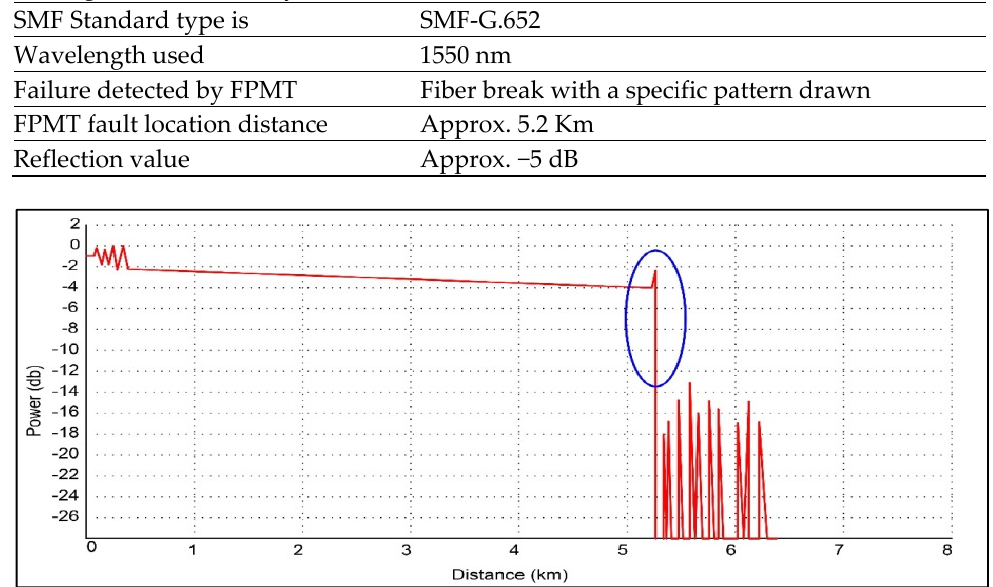
Figure 8. Fiber break event (standard SMF G.652 at 1550 nm used and FPMT test signal was transmitted by the OSC board).